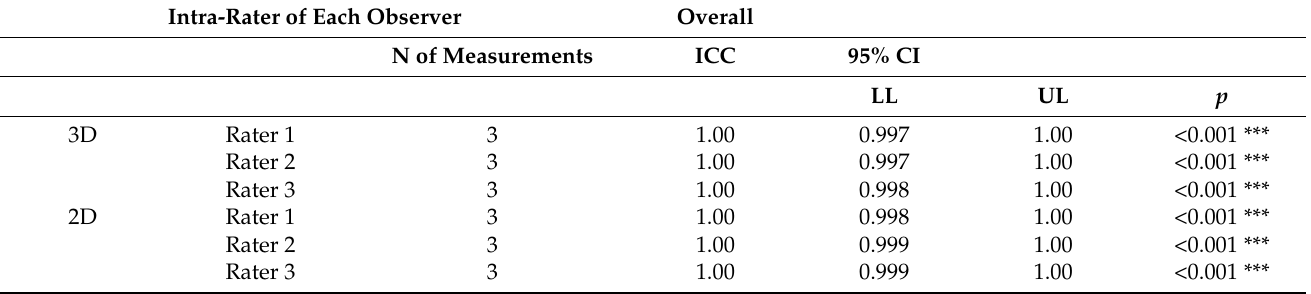
Table 1. Results of the ICC calculations for the intra-rater reliability. Intra Class Coefficient (ICC), Confidence Interval (CI), Lower (L), and Upper (U) limits; statistical significance (*).